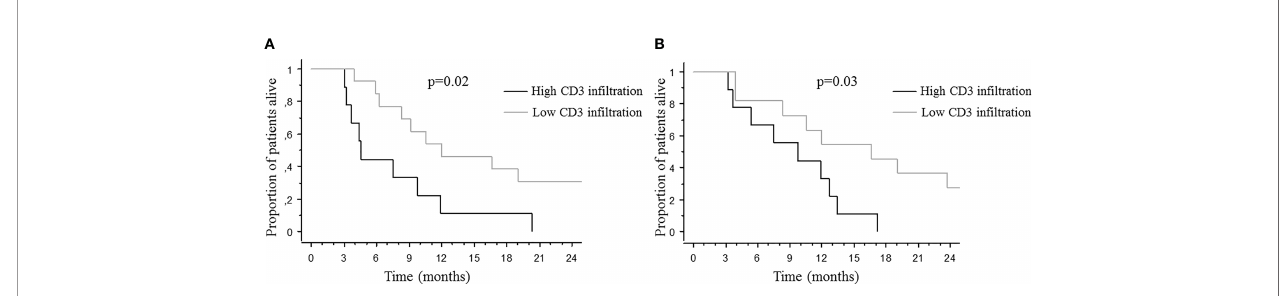
FIGURE 6 | Median overall survival after brain metastases diagnosis according to CD3 T-cell in fi ltration in BM among patients with colon cancer (A) and supratentorial BMs (B) . Kaplan-Meier method was used to determine OS. CD3 T-cell in fi ltration score was split at median and p value calculated using the